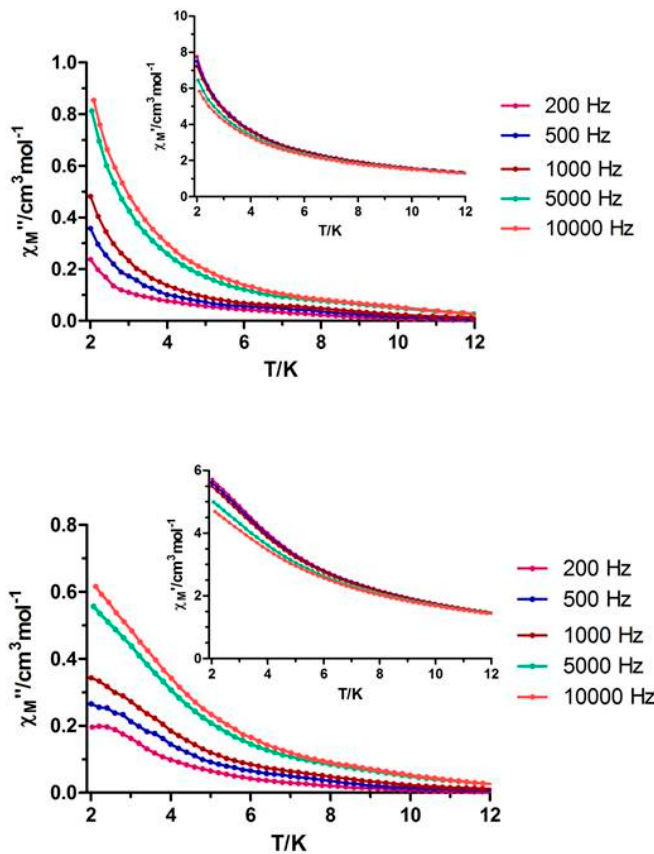
Figure 6. ( Top ) Temperature dependence of in-phase χ ′ M (inset) and out-of phase χ″ M components of the alternating current (AC) susceptibility for complex 2 under zero applied external field; ( Bottom ) Temperature dependence of in-phase χ ′ M (inset) and out-of phase χ ″ M components of the alternating current (AC) susceptibility for complex 2 under an applied field of 1000 Oe.